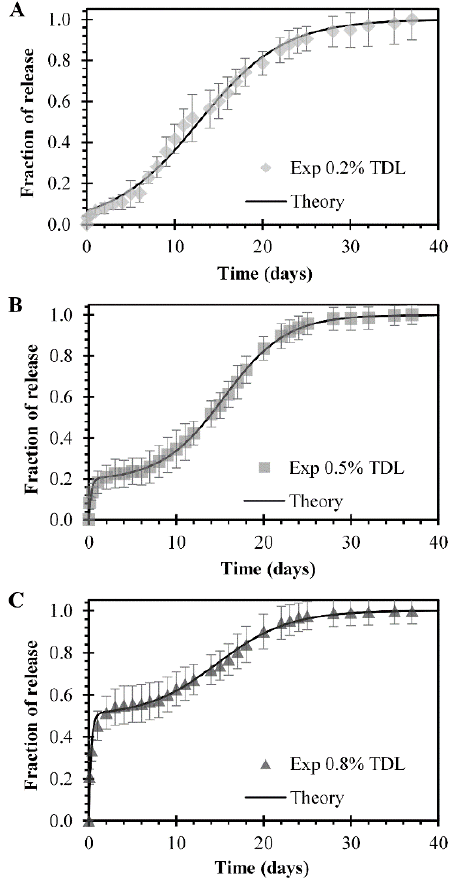
Figure 5. In vitro pVAX1-NH36 release profiles from pDNA-NP for theoretical pVAX1-NH36 loadings (TDL) of 0.2% ( (cid:95) ), 0.5% ( (cid:4) ) and 0.8% ( (cid:78) ). Data represent mean ( n = 3). Table 2. Parameters of plasmid pVAX1 ‐ NH36 release from pDNA ‐ NP. The parameters were determined and used in the mathematical development of the release model.